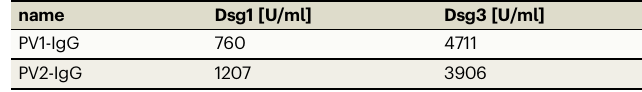
Table 1 | Dsg autoantibody levels of patient-IgGs